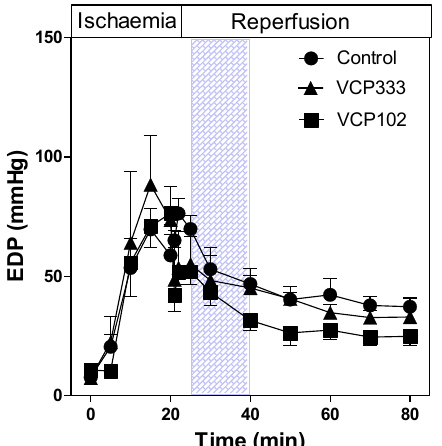
Figure 3. The effect of 15-min allosteric modulator VCP333 (1 µM) or VCP102 (10 µM) infusion on end diastolic pressure (EDP) in mouse isolated hearts following 20-min of